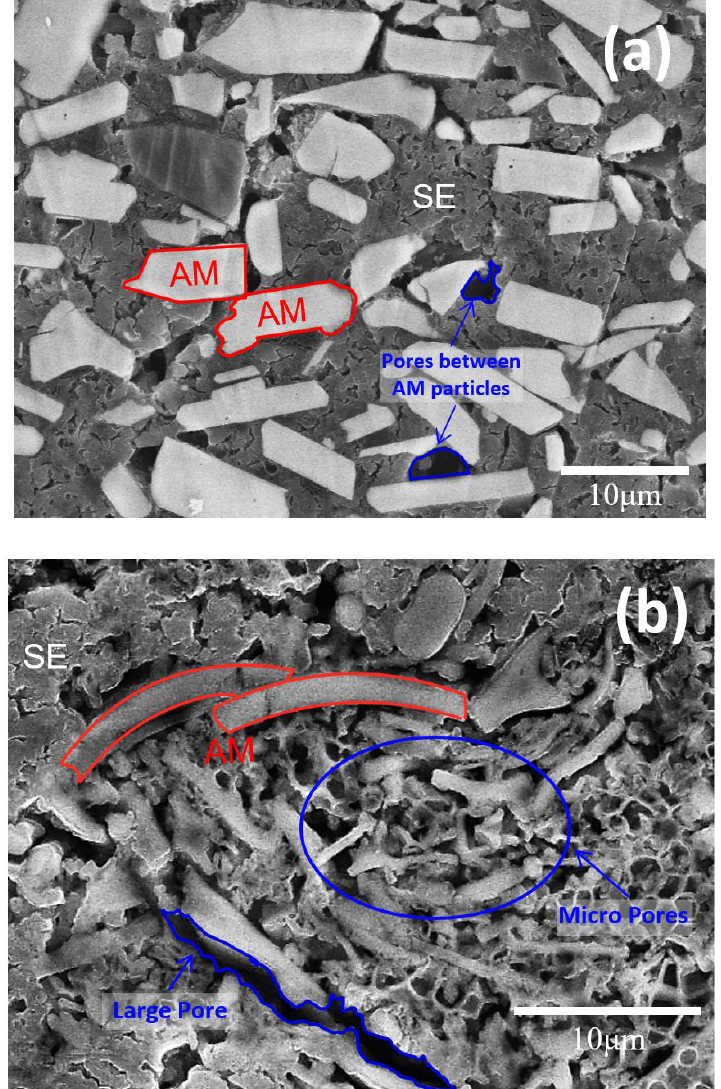
Figure 5. Cross-sectional views of the composite electrodes containing ( a ) plate-shaped and ( b ) fi- brous particles at low volume fraction of solid electrolyte ( ε SE,1 = 0.32). AM: active material. SE: solid electrolyte.